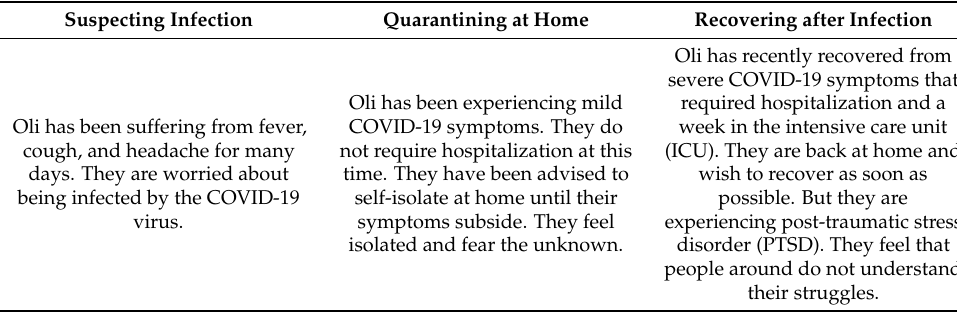
Table 1. Patient Personas for Study 1. Oli Smith lives in United States, owns a smartphone and has no underlying health condition, is playing the role of the persona in each